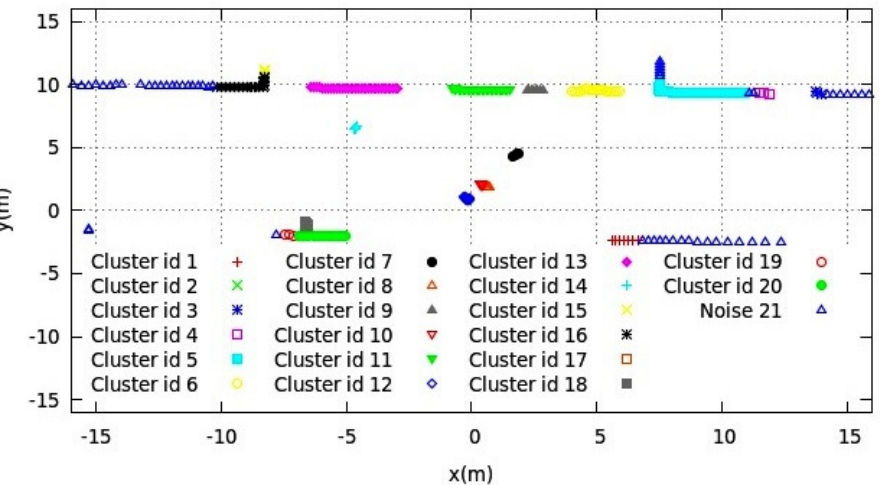
Figure 4. Clustered Laser Data. It shows the laser points after applying DBSCAN (Density-Based Spatial Clustering of Applications with